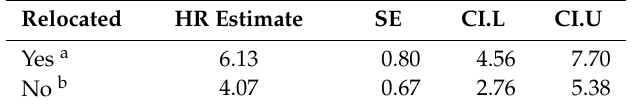
Table 5. Raw mean home range estimates with standard error (SE) and 95% confidence intervals (CI.L and CI.U) for T. carolina by relocation status. Superscript letters show di ff erences among